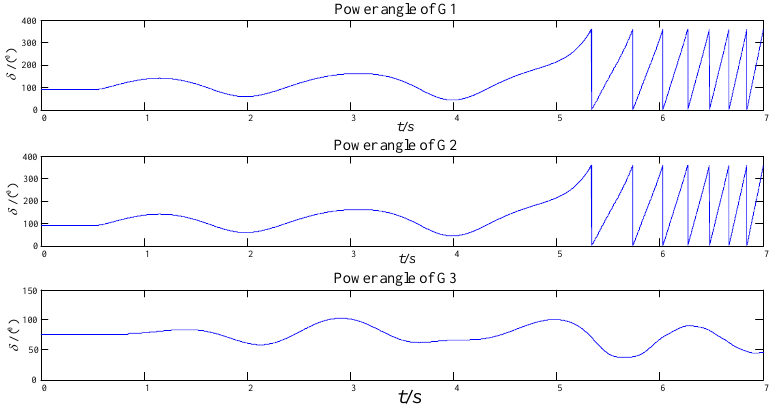
Figure 11. Power angle curve of the equivalent generators.